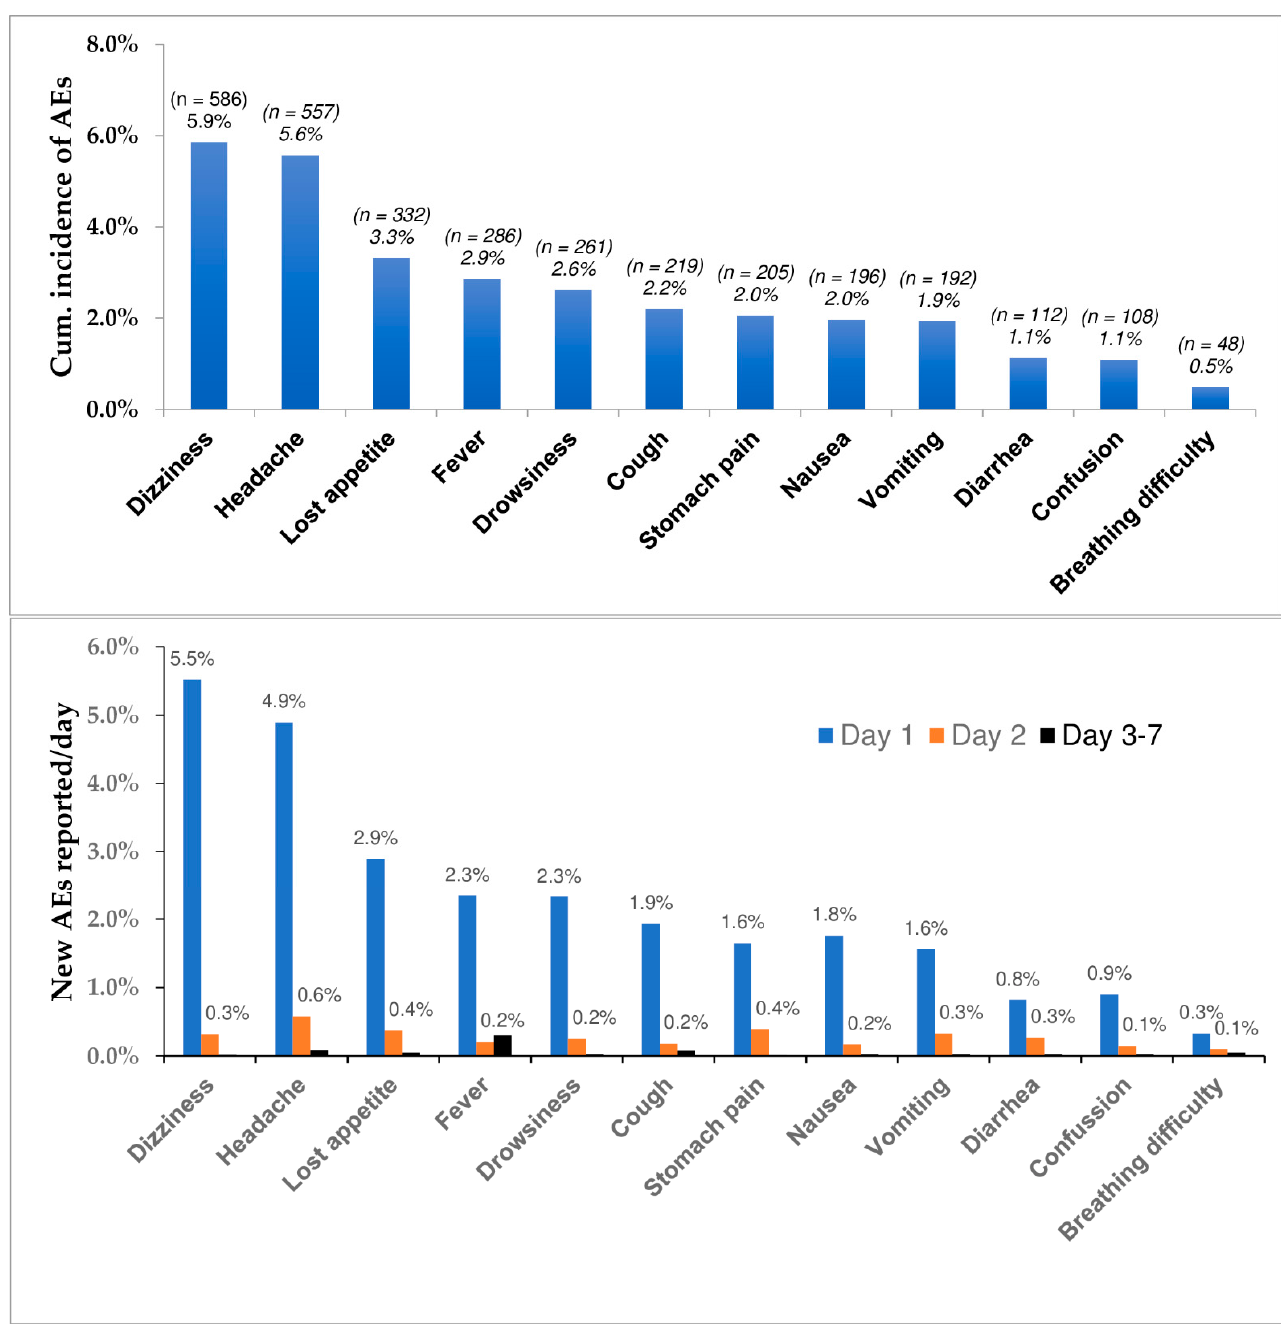
Figure 2. Cumulative incidence of post- mass drug administration (MDA) adverse events (AEs) over 7 days post-MDA (top), and incidence of new AEs reported per day (bottom) following mass diethylcarbamazine plus albendazole administration.